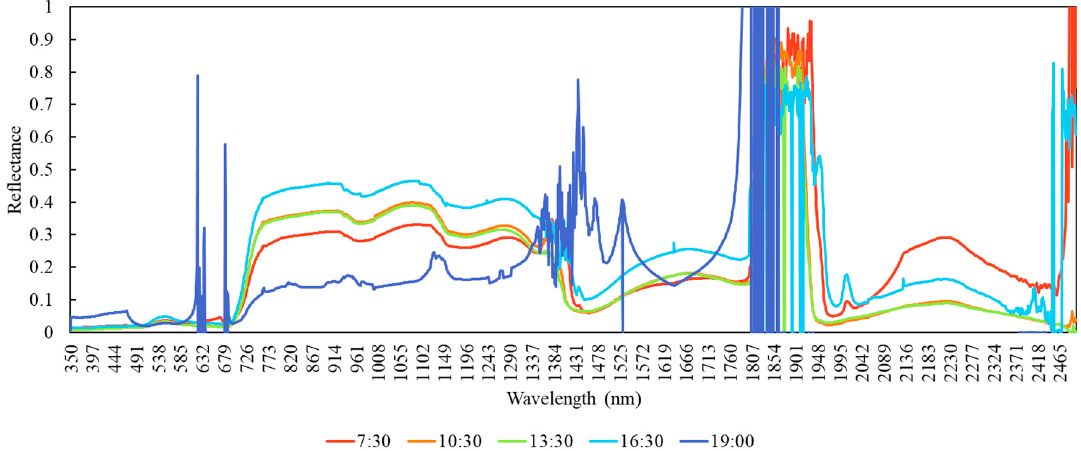
Figure 2. Land surface reflectance from the visible to shortwave infrared spectral region at 7:30 a.m., 10:30 a.m., 1:30 p.m., 4:30 p.m., and 7:00 p.m. at local time on 21 August 2015 (DoY 234).